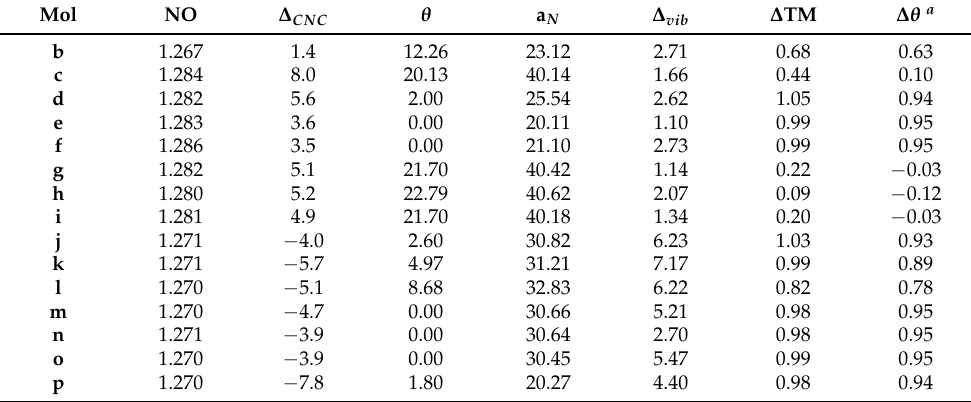
Table 6. Equilibrium NO bond length (Å), out of plane angle θ (in degrees) and a N (in MHz) computed at the B2 level together with high-level corrections from the template molecule model ( ∆ TM in MHz) and B3 vibrational corrections at 300 K ( ∆ vib in MHz). In the last column, the correction obtained by Equation (1) ( ∆ θ in MHz) is reported. The column ∆ CNC reports the difference between the CNC angle of the real system and that of the dimethylnitroxide model ( a ) at the same θ angle. Mol NO ∆ CNC θ a N ∆ vib ∆ TM ∆ θ a b